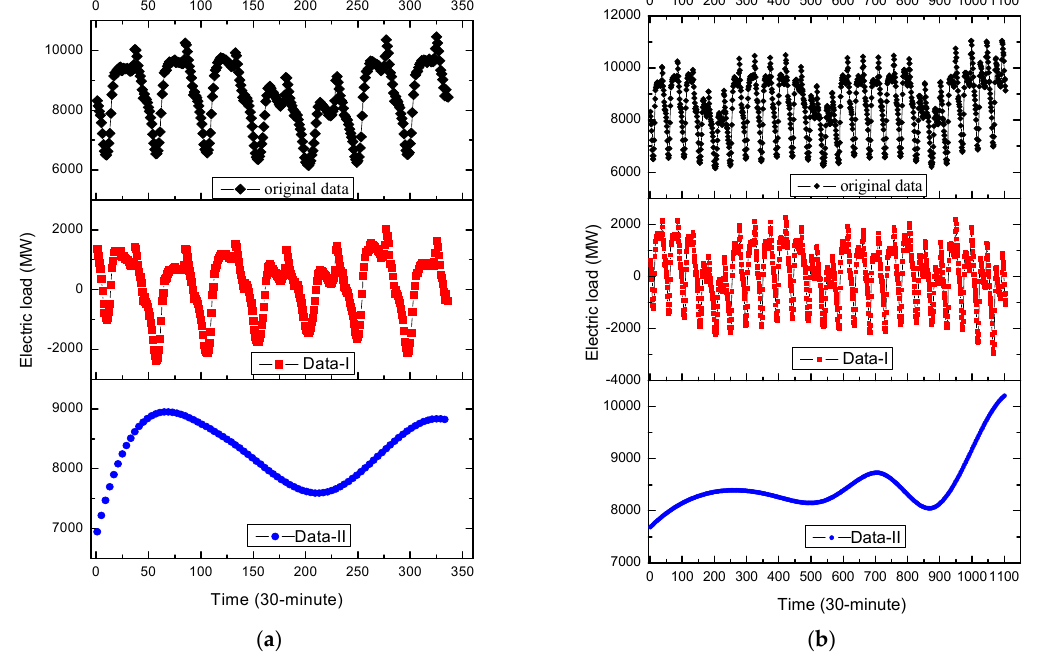
Figure 5. The 30-min based original data, Data-I, Data-II (Example 1). ( a ) Small data size (2–8 May 2007); ( b ) Large data size (2–24 May 2007).